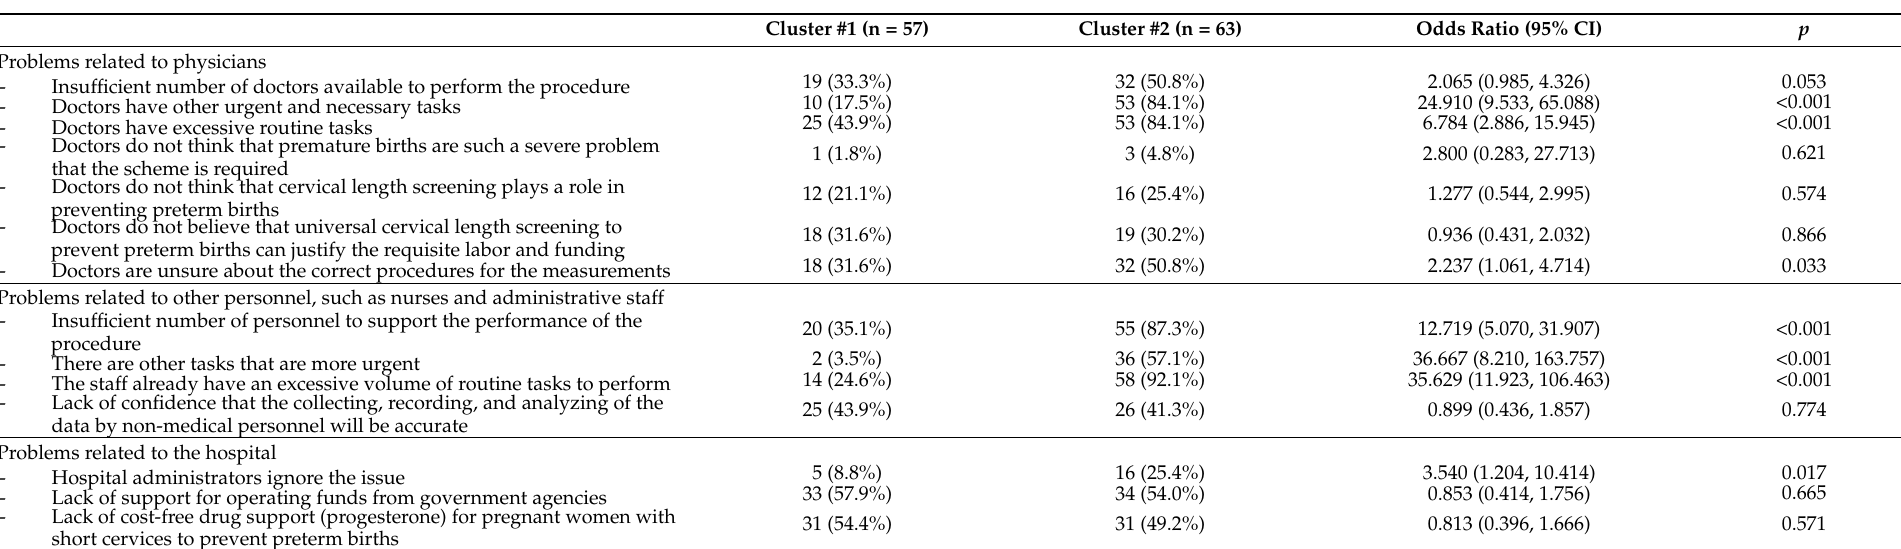
Table 7. Cluster analysis by grouping physicians who stated that both heavy workloads and a lack of government funding were major